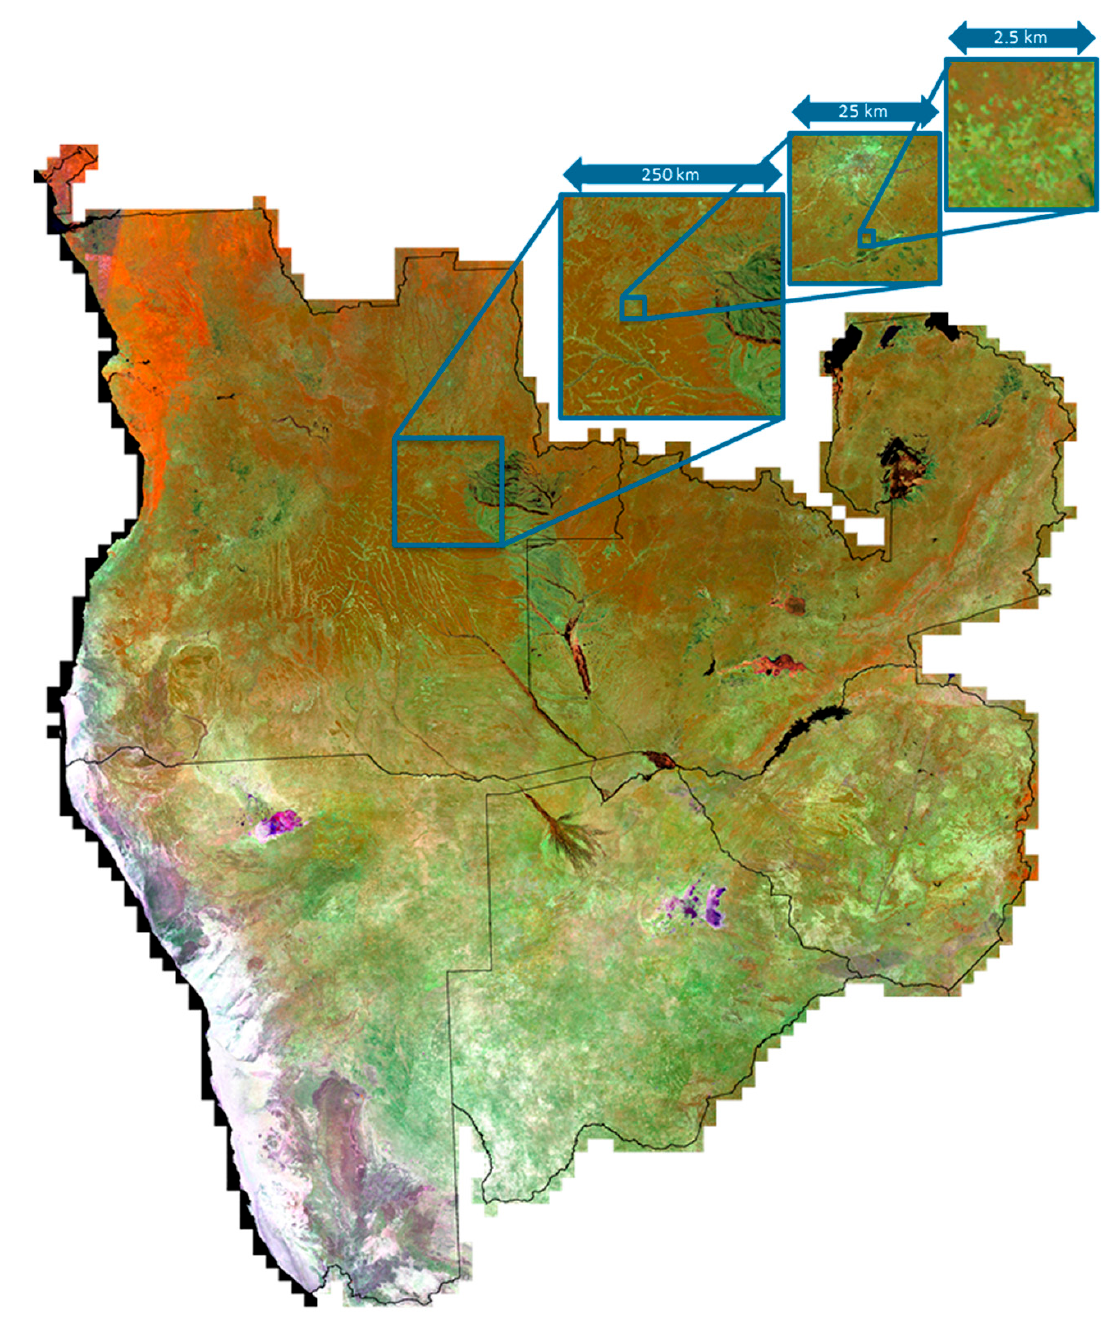
Figure 9. Best-available-pixel composite (near-infrared, shortwave infrared, red in RGB) for Angola, Zambia, Zimbabwe, Botswana, and Namibia. The 250, 25, and 2.5 km subsets provide different zoom levels of the composited data. The composite is temporally centered at the end of season land surface phenology metric for 2018. The land surface phenology was derived from the Moderate Resolution Imaging Spectroradiometer (MODIS), and its spatial resolution was enhanced with the FORCE ImproPhe code (see Section 3.3.5).